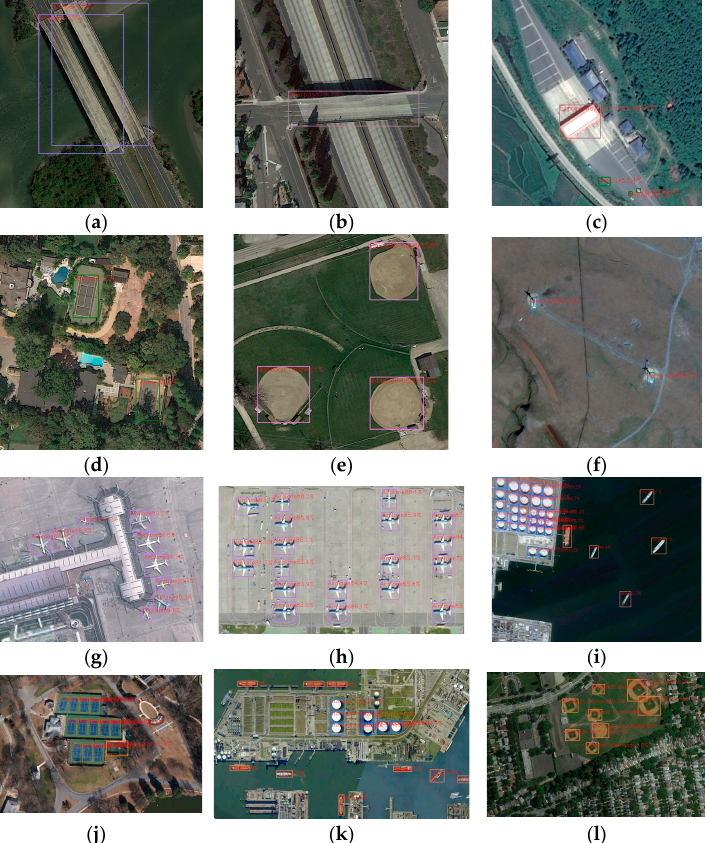
Figure 11. Visualization result of detection. ( a – f ) are test results on the DIOR dataset and ( g – l ) are test results on the NWPU-VHR-10